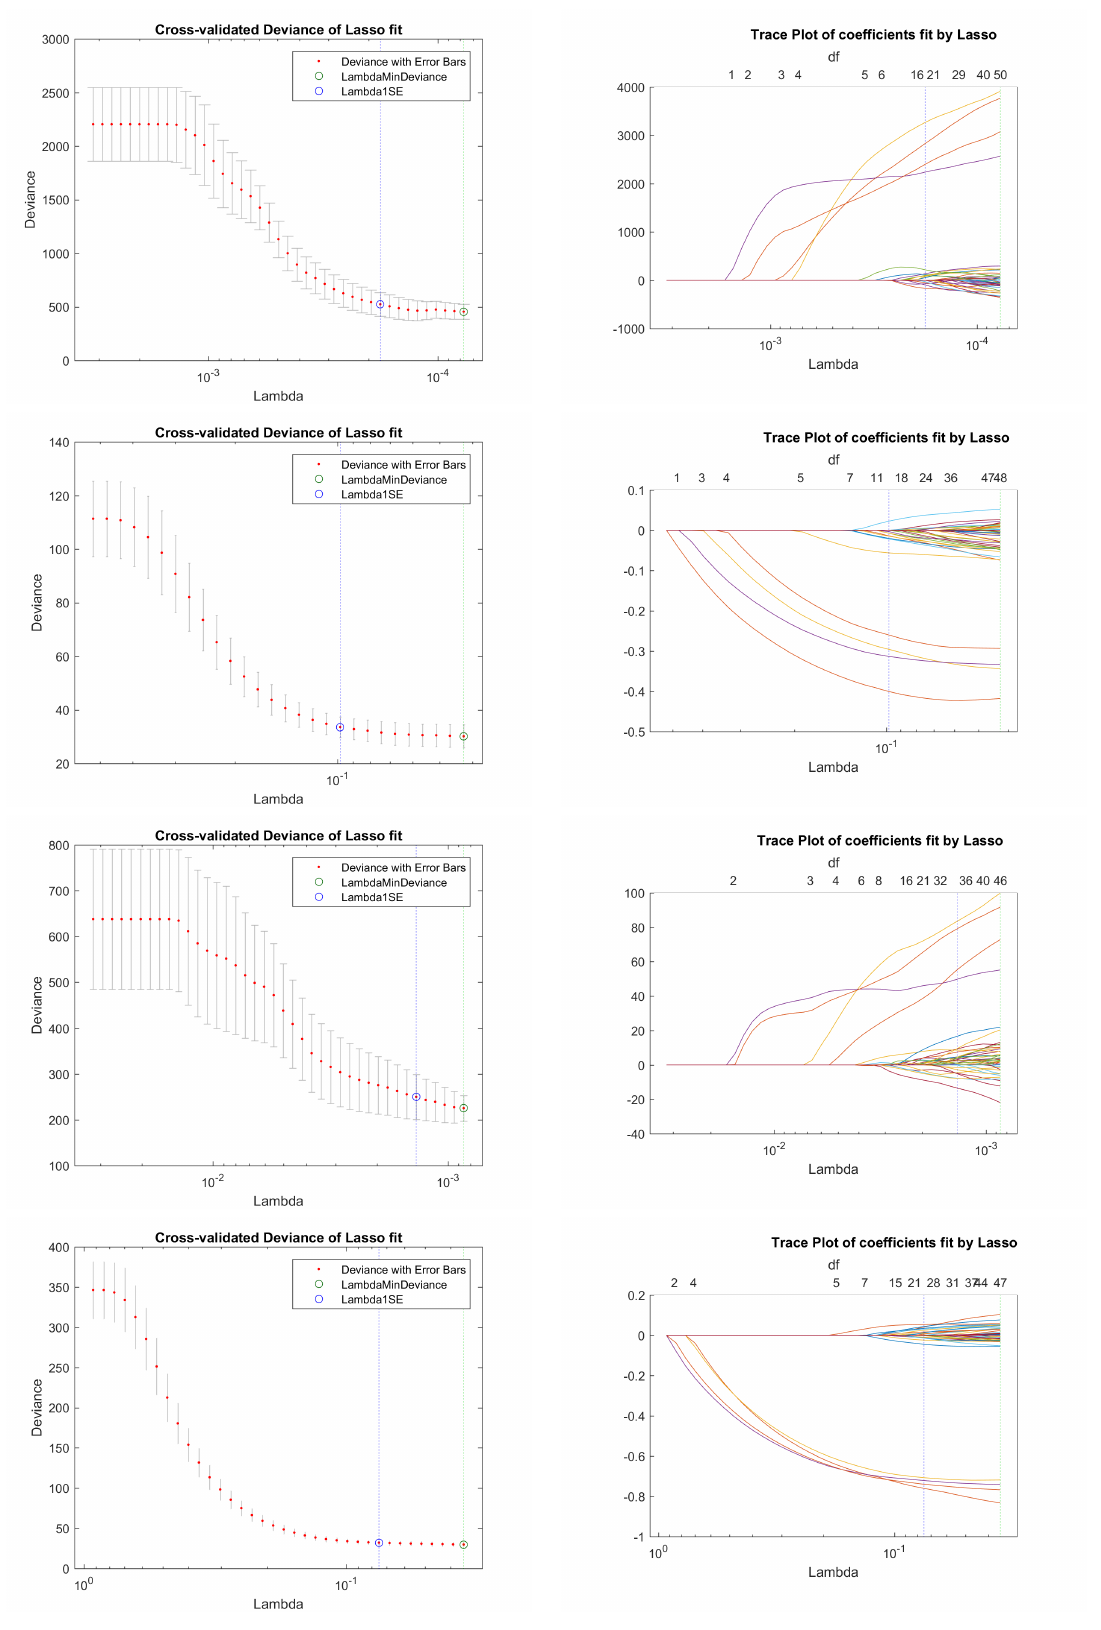
Figure 2. Base case scenario: cross-validation for simple fitting models. From top to bottom, they are the cross-validation plots for four models with an order of: IG-ig, BC-ibc, BC-ig, and